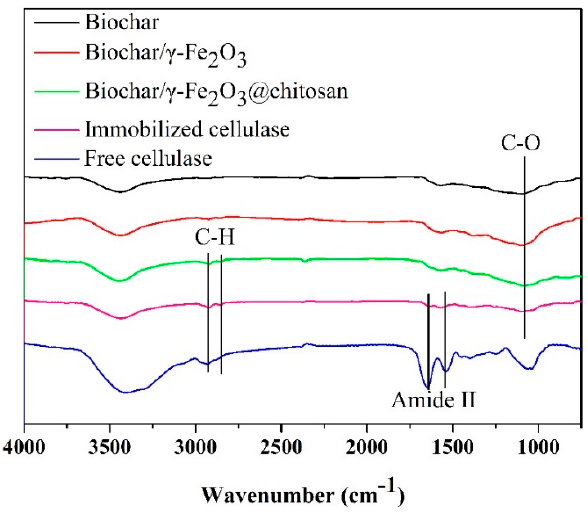
Figure 5. Fourier transform infrared spectroscopy (FT-IR) spectra of the biochar ( black curve ), biochar/ γ -Fe 2 O 3 ( red curve ), biochar/ γ -Fe 2 O 3 @chitosan ( green curve ), immobilized cellulase ( pink curve ), and free cellulase ( blue curve ).